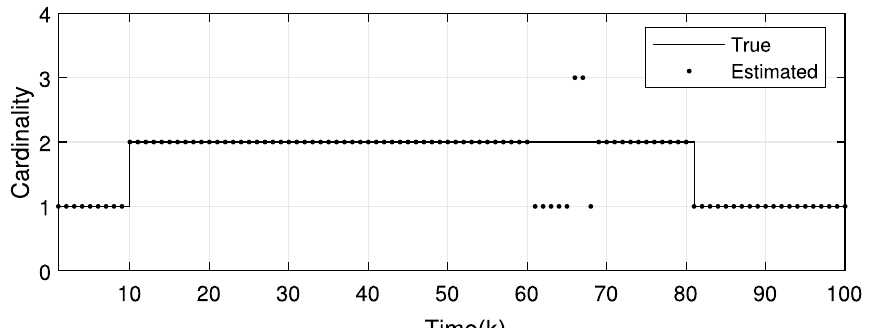
Fig. 18 Estimation of the number of